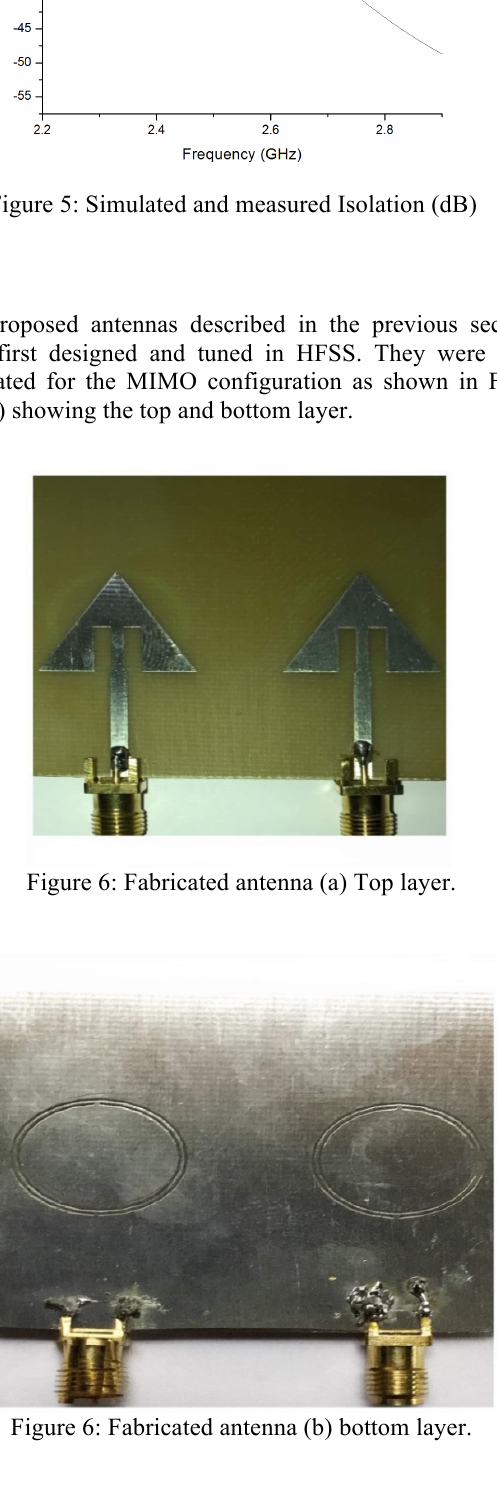
Figure 6: Fabricated antenna (b) bottom layer.